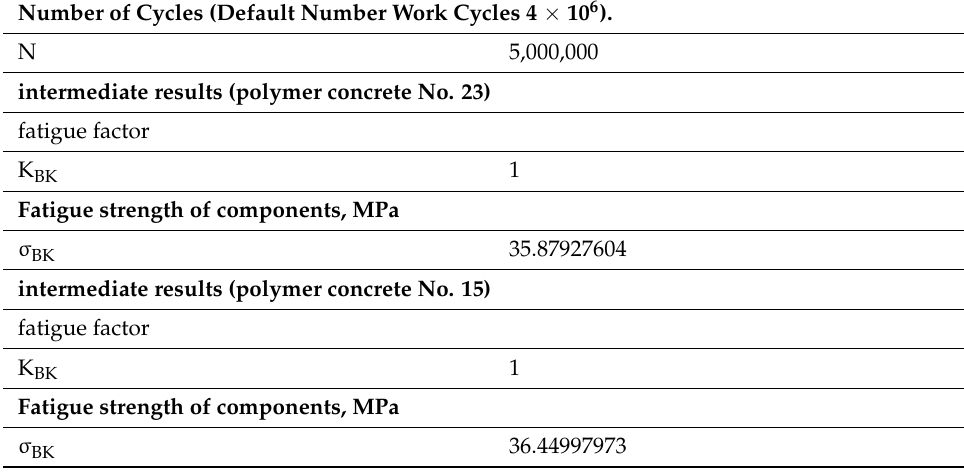
Table 7. The effect of the number of working cycles on the model strength. Number of Cycles (Default Number Work Cycles 4 × 10 6 ).